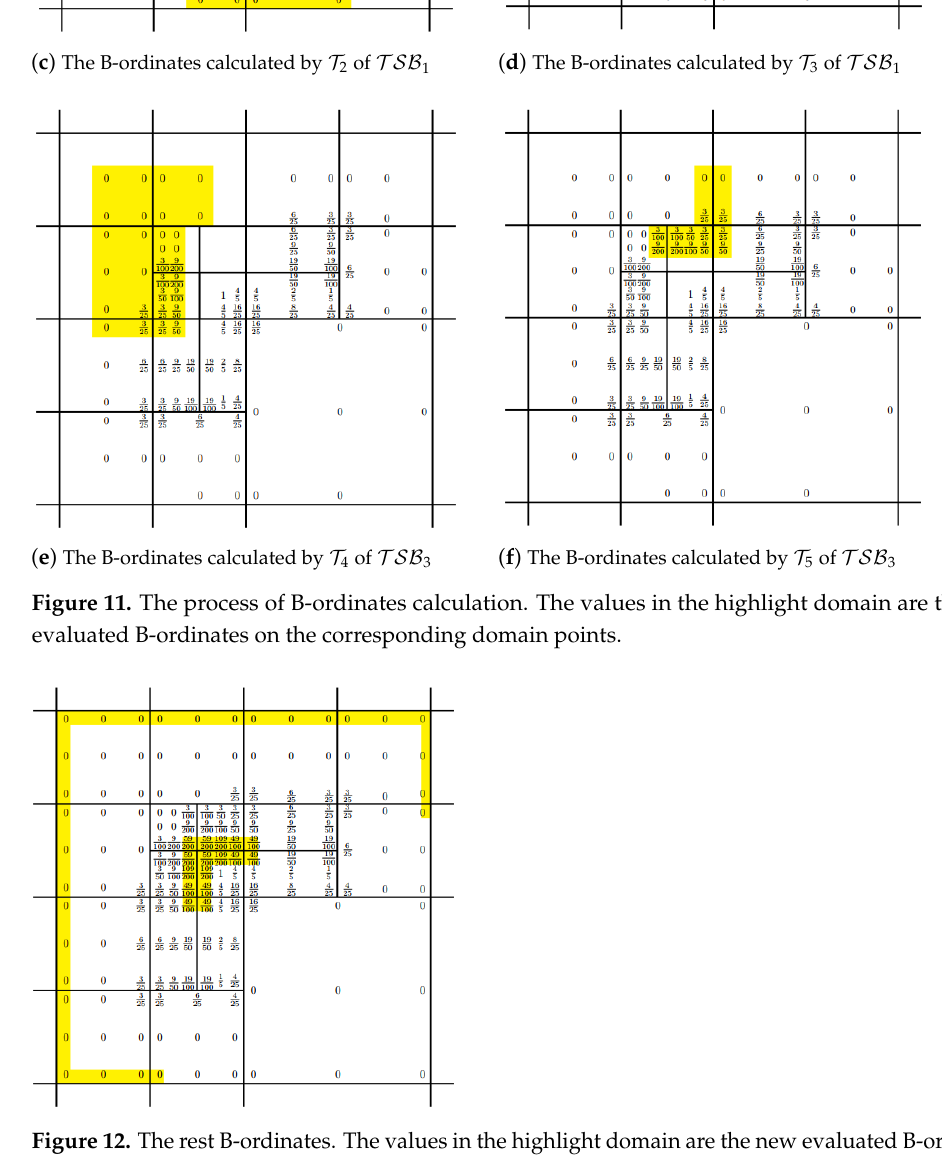
Figure 12. The rest B-ordinates. The values in the highlight domain are the new evaluated B-ordinates on the corresponding domain